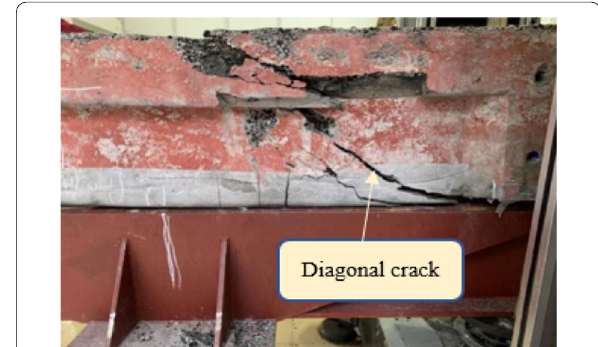
Fig. 3 Destruction of ceramsite concrete beam.